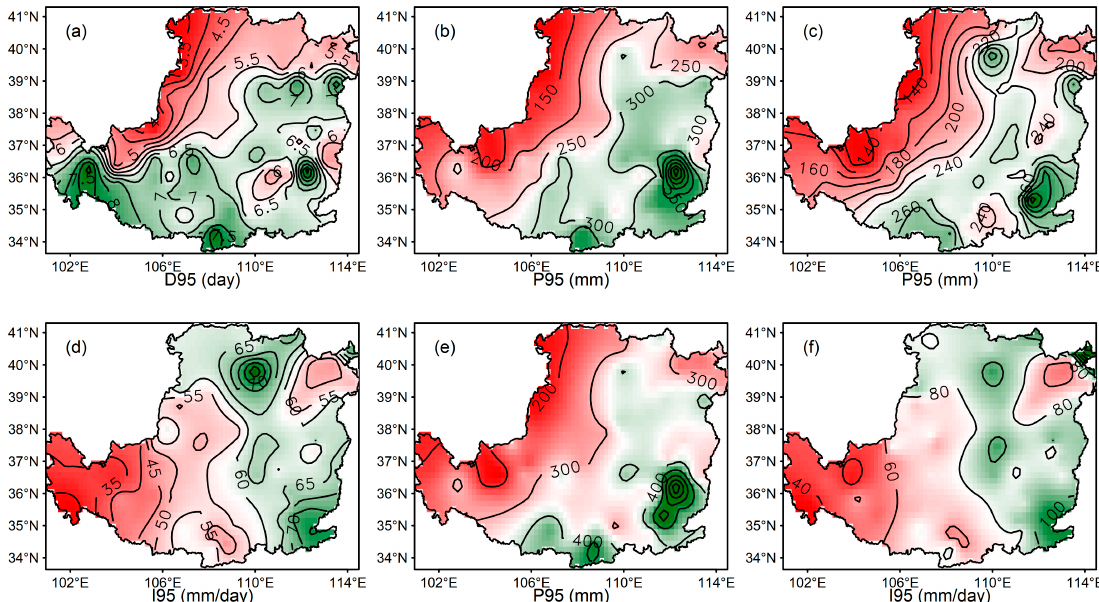
Figure 7. The specific values for each individual indicator under joint return period of 50 years corresponding to three combination groups: ( a ) and ( b ) correspond to the {D95_R, P95_R} event; ( c ) and ( d ) correspond to the {P95_R, I95_R} event; ( e ) and ( f ) correspond to the {P95_R or I95_R} event.